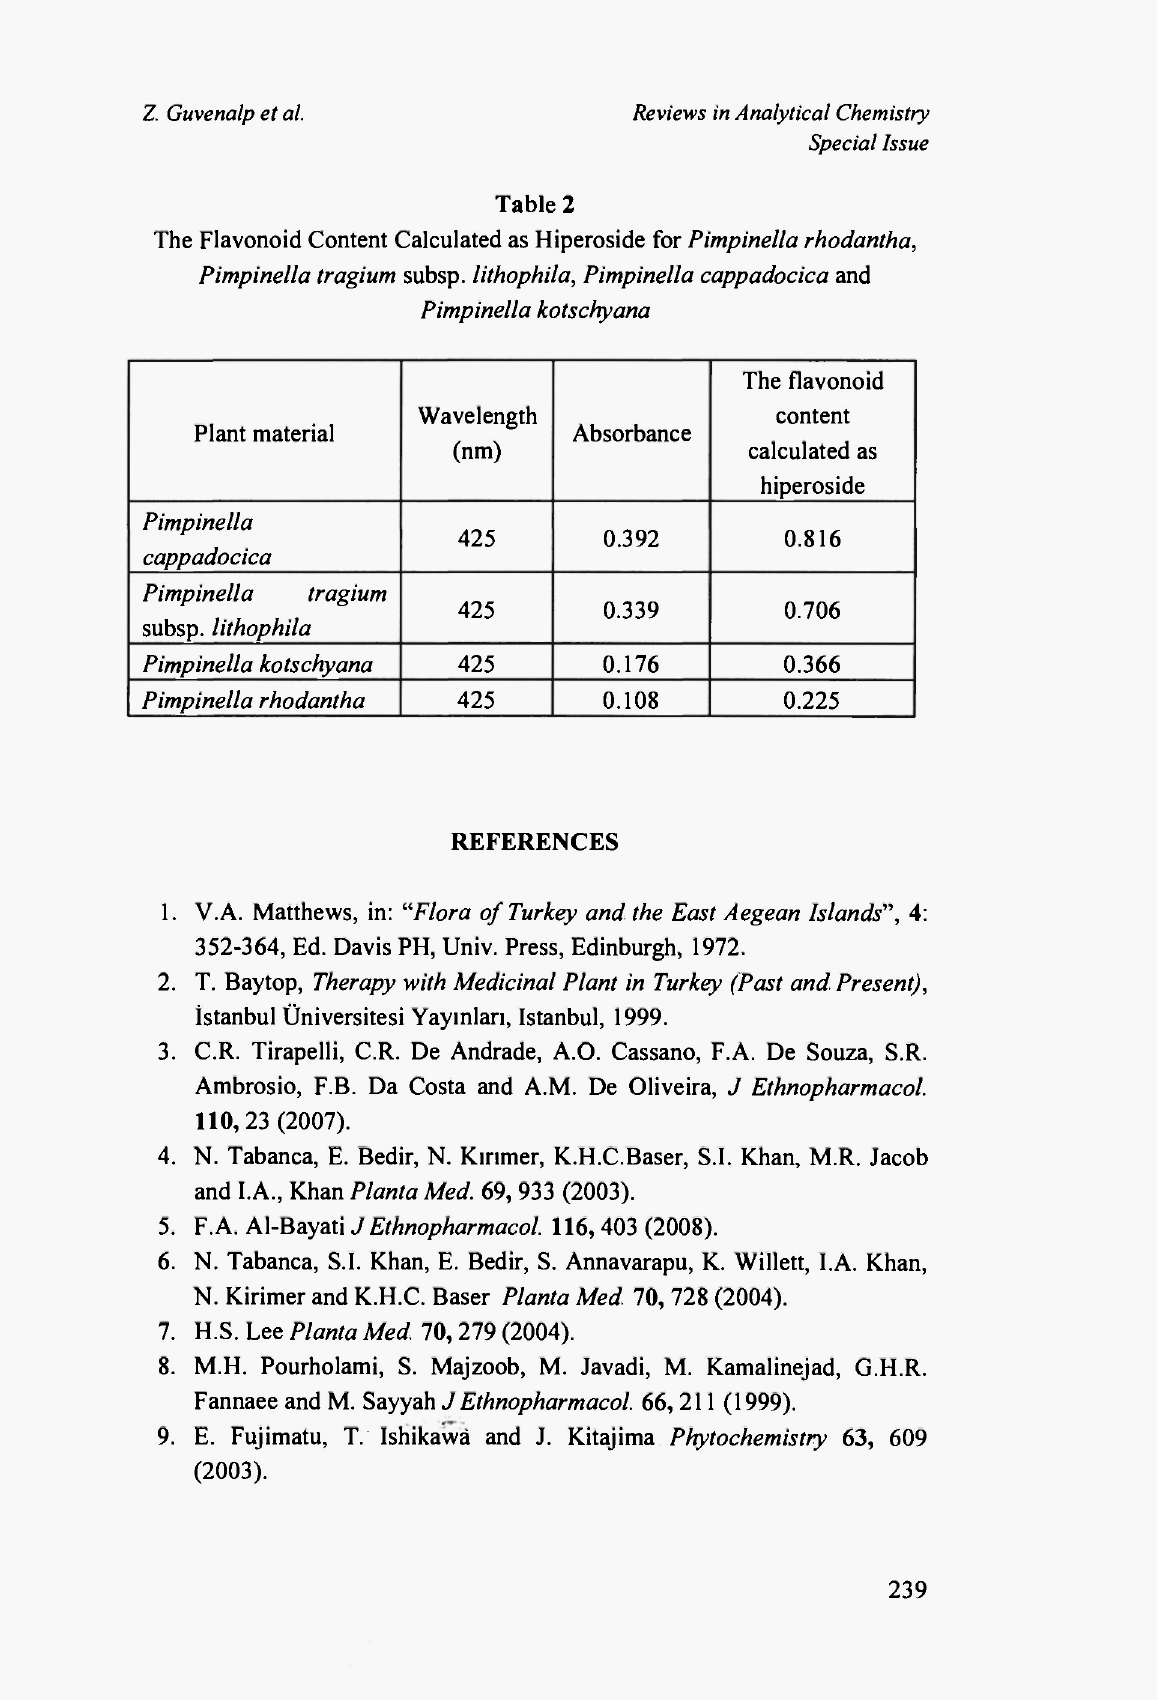
The Flavonoid Content Calculated as Hiperoside for Pimpinella rhodantha, Pimpinella tragium subsp. lithophila, Pimpinella cappadocica